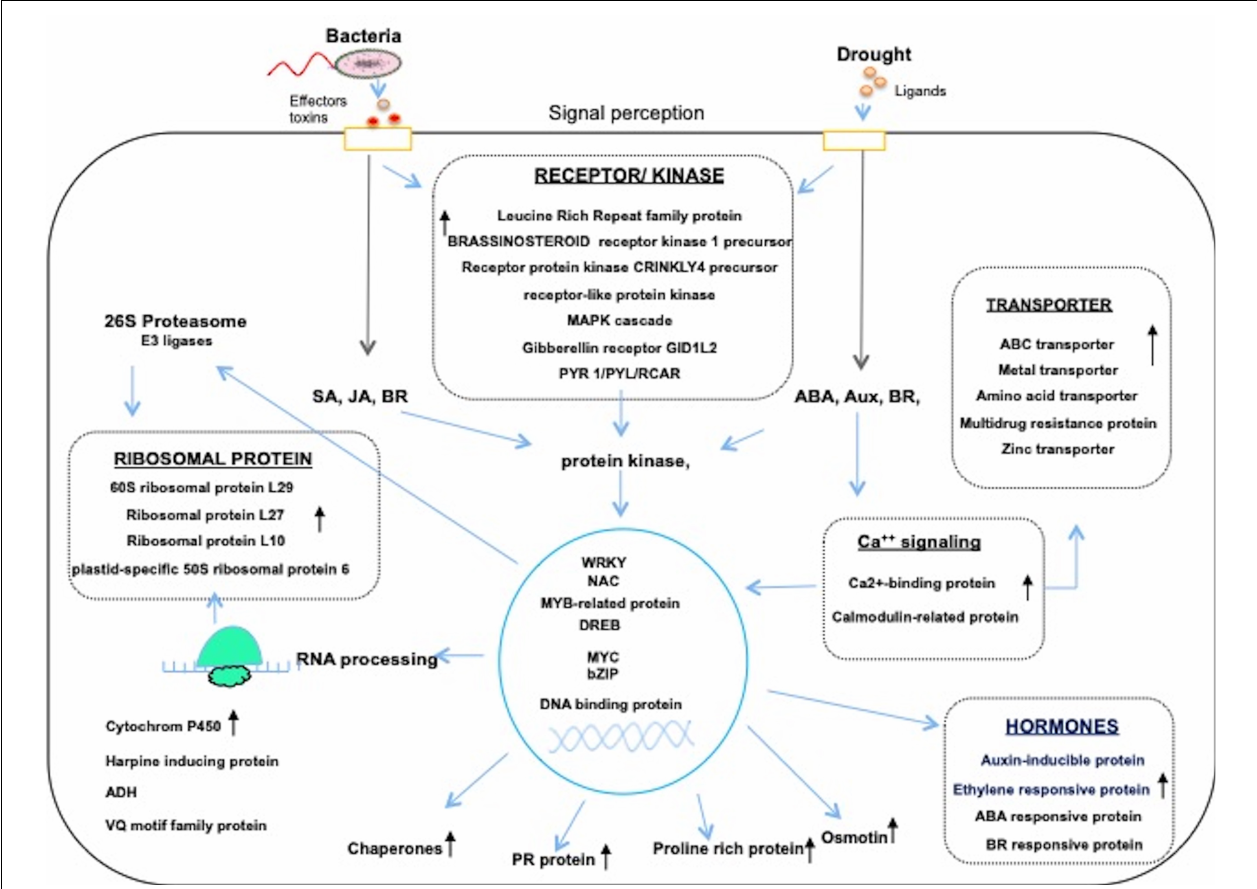
FIGURE 1 | The molecular responses under drought and Xoo infection in Rice. The stress signals from biotic and abiotic stresses are perceived by specific receptors and cascade of signaling processes such as protien Kinases, TFs, transporters, ribosomal protiens, and many hormone responsive genes are differentially co-regulated in both drought and pathogen stress. The transcriptional regulators which play central role enhances the transcripts of diverse functional genes and ribosomal proteins translate the message in to protein to maintain cellular homeostasis under combined stress Many of these genes were upregulatcd under combined stress have relevance in improving stress adaptation (Narsai et al., 2013; Huang et al., 2014; Zhang et al.,